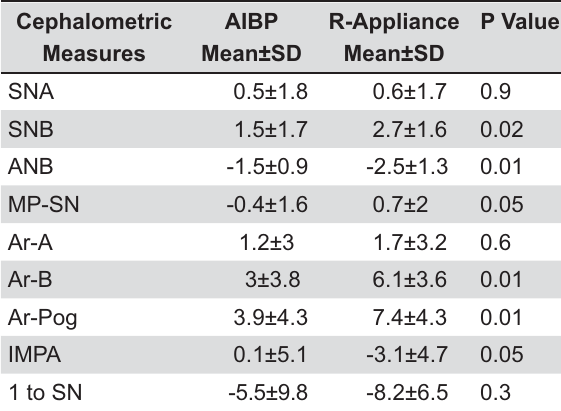
treatment and after R-appliance treatment. Table 3- Comparison of R-appliance and Anterior Inclined Bite Plate (AIBP) group